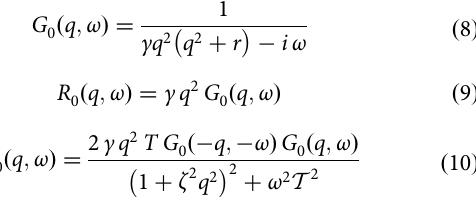
parameters mentioned at the beginning of this